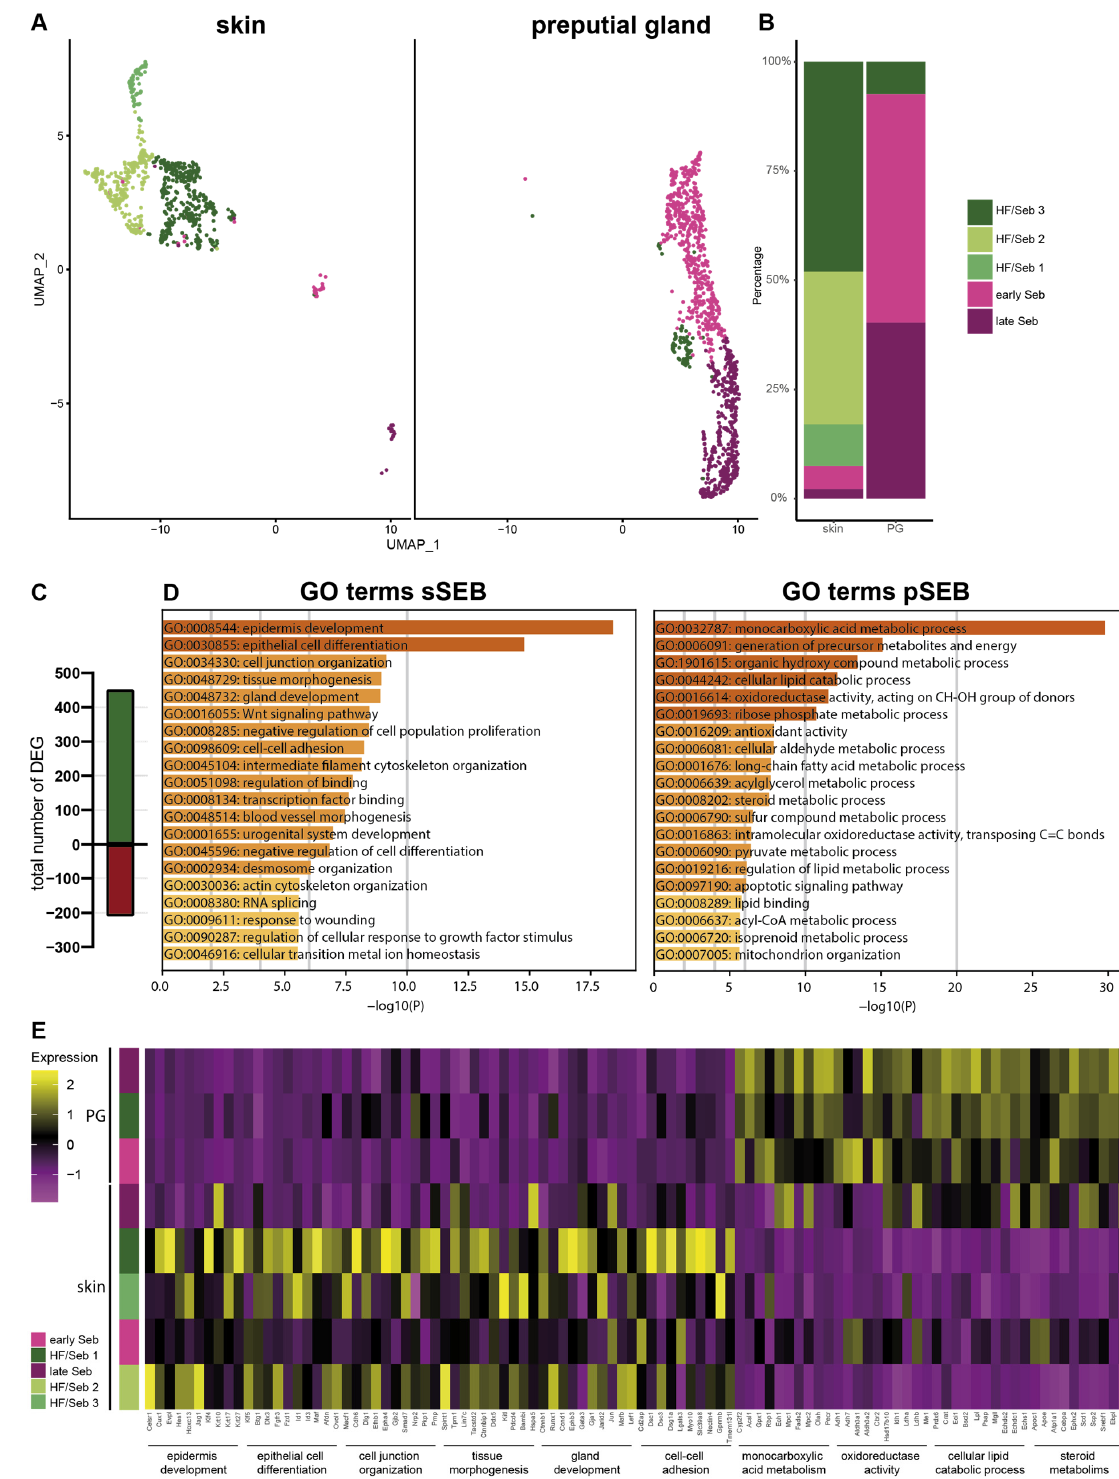
Figure 2. Subclustering of sebocytes and Gene Ontology analysis ( A ) Analysis of the sebocyte subcluster identified five distinct subtypes in UMAP-plot. Subclusters were identified as HF/SEB 1, HF/SEB 2, HF/SEB 3, early SEB and late SEB. ( B ) Barplot indicates relative cell numbers present within each sebocyte subcluster. ( C ) Barplot shows the total number of differentially expressed genes of total sSEB compared to total pSEB. ( D ) Gene Ontoloy (GO) term analysis results using Metascape. Genes with a differential expression fold change of >1.5 or <0.6 were assigned to GO terms. ( E ) Heatmap showing expression levels of genes associated with distinct GO terms in the different SEB subclusters.